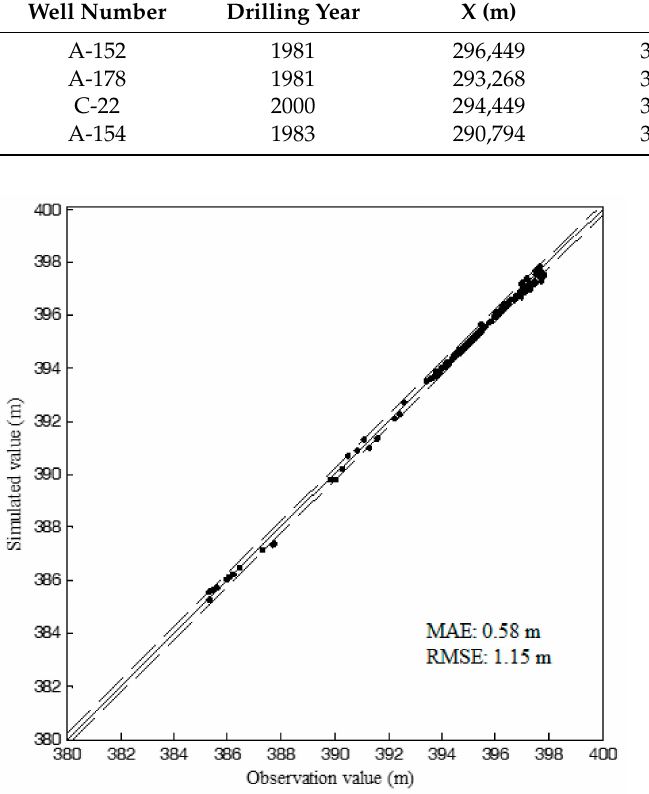
Figure 9. Comparison between observed and simulated water levels. Dotted lines indicate the 95% prediction